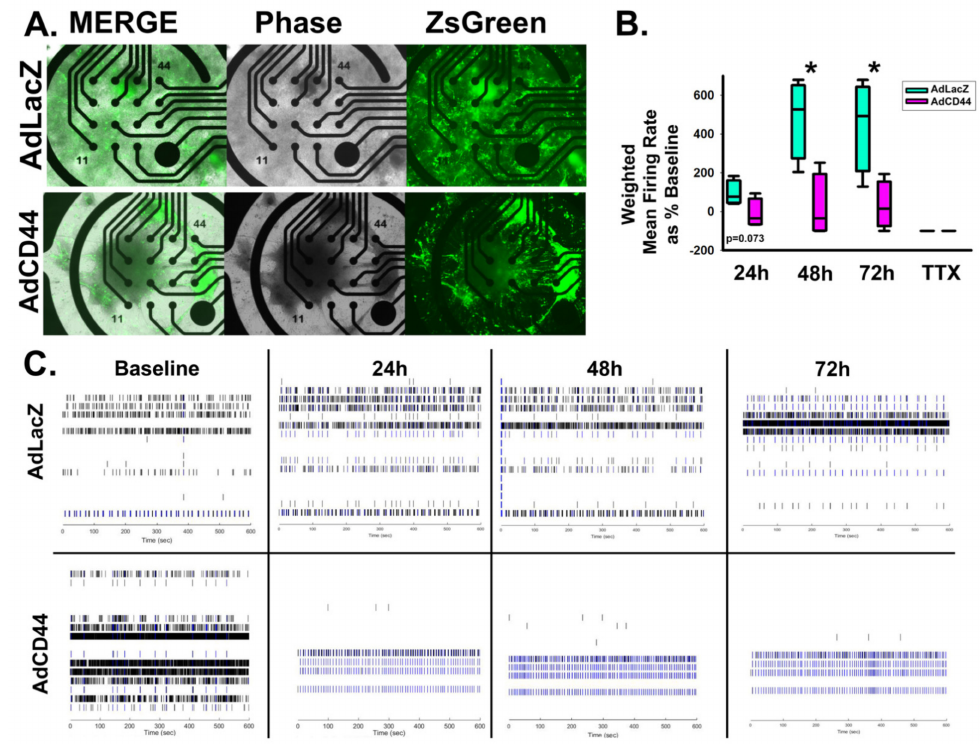
Figure 8. CD44 suppresses excitability of developing neural networks. ( A ) Representative images of successful viral transduction on MEA plates as indicated by viral expression of ZsGreen in dissociated spheroid transduced with adenovirus constructs for control LacZ (AdZsGrnLacZ) and